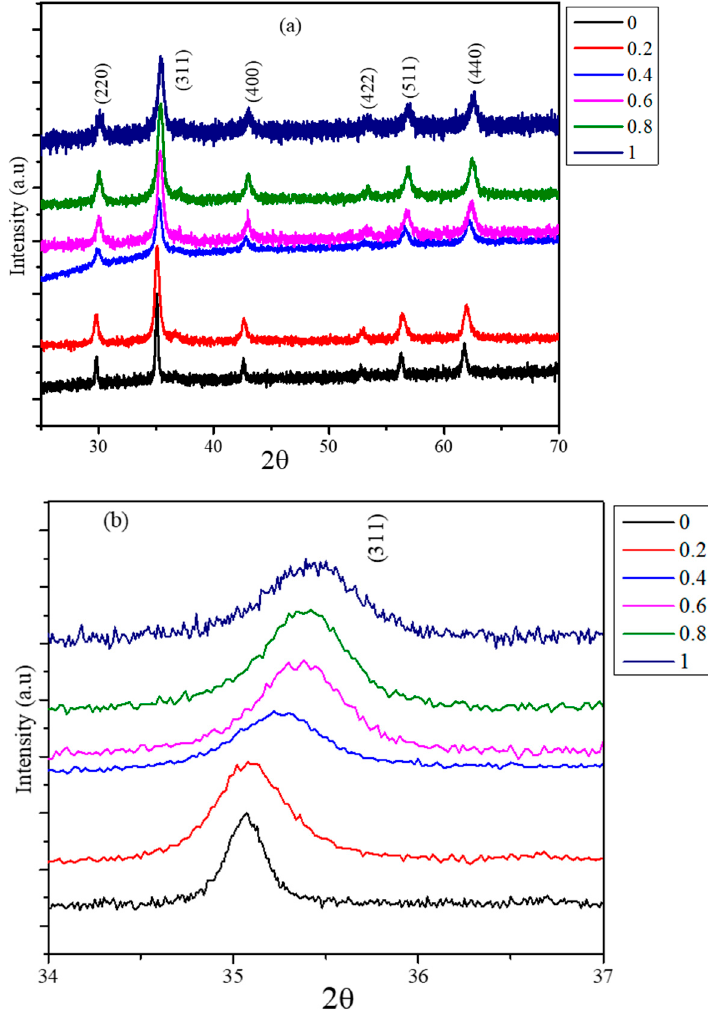
Figure 1. ( a ) X-ray diffraction patterns of Co x Mn 1-x Fe 2 O 4 ( x = 0, 0.2, 0.4, 0.6, 0.8, and 1.0) nanoparticles. ( b ) Highest intensity peak (311) position shift with respect to cobalt concentration. Table 1. The average crystallite sizes and lattice parameters of the Co x Mn 1-x Fe 2 O 4 ( x = 0, 0.2, 0.4, 0.6, 0.8, and 1.0) nanoparticles.